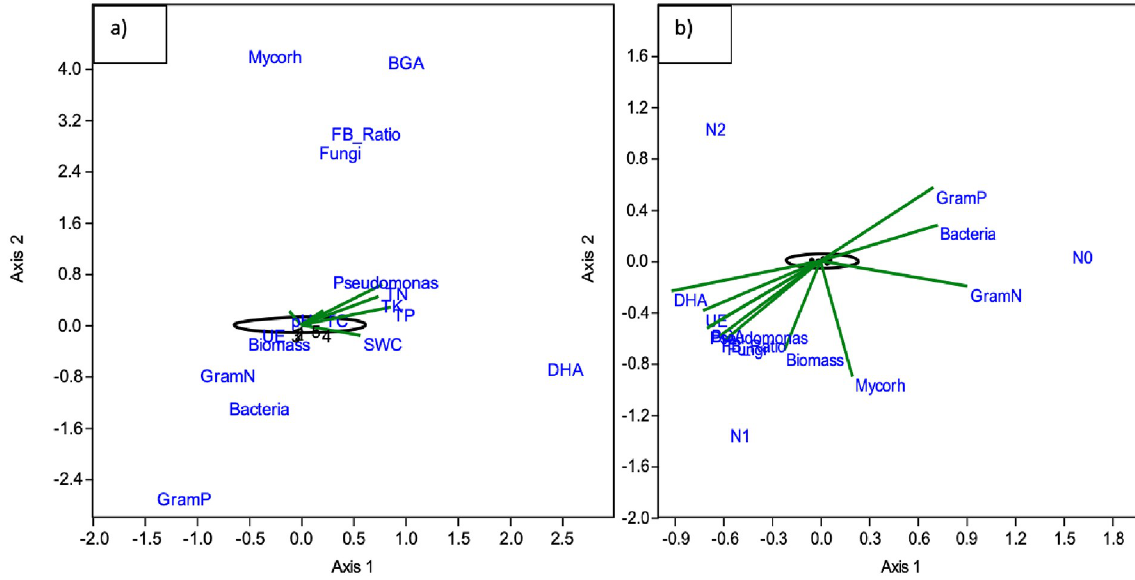
Fig 6. Canonical correspondence analyses revealed associations between soil physical, chemical, and biological properties in turfgrass soils with and without compost and biochar amendments. (a) compares soil properties, PLFA-based microbial groups and enzyme activities (b) compares PLFA-based microbial groups, enzyme activity and nitrogen stimulated-substrate induced respiration